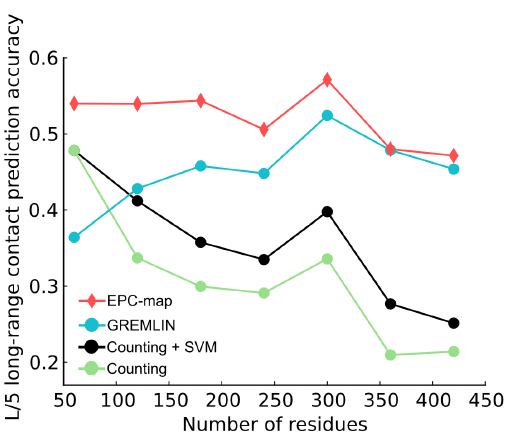
Figure 7. Dependence of prediction accuracy on sequence length. EPC-map is more accurate or on par with GREMLIN, irrespective of sequence length. The performance increase over GREMLIN is most pronounced for proteins smaller than 250 residues. Counting performs better on smaller proteins. The SVM component of EPC-map consistently improves the contact prediction from decoys over Counting by leveraging physicochemical information.